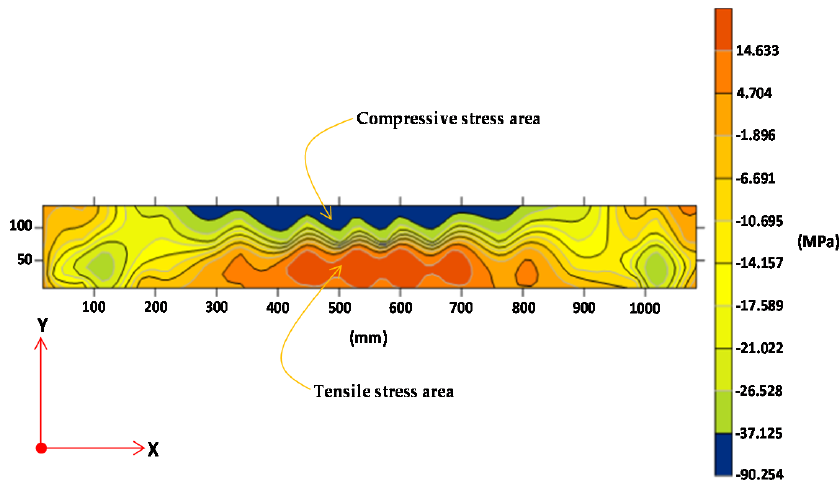
Figure 17. The stress contour of X-direction of BRC beam.